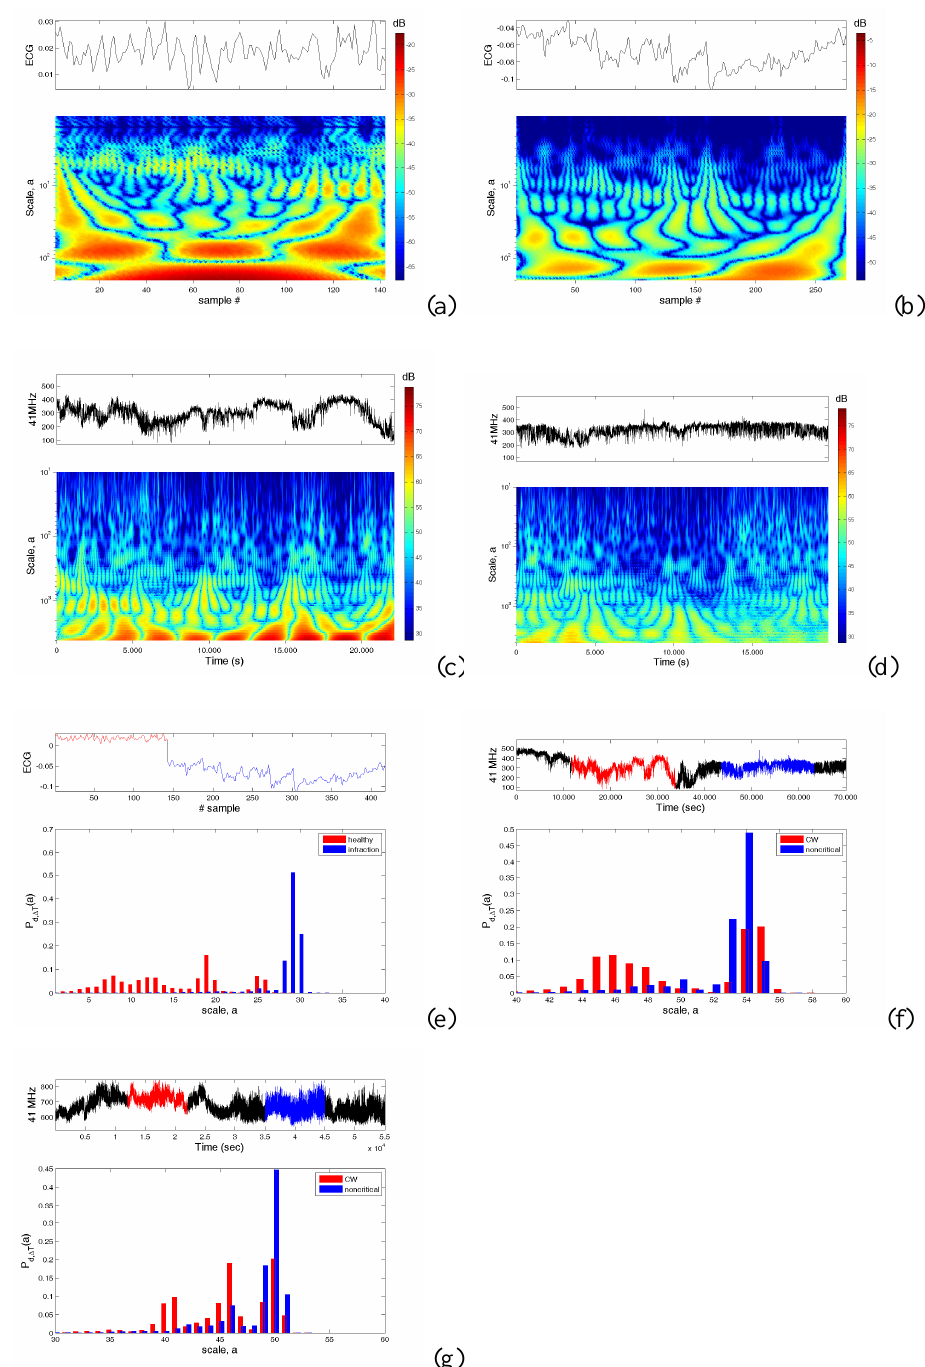
Fig. 5. (a) Morlet wavelet power scalogram (in dB) of an indicative relaxation interval of the healthy heart taken from the ECG time series of the subject “p121”. (b) Morlet wavelet power scalogram (in dB) of an indicative relaxation interval of the pathological heart taken from the ECG time series of the subject “p023”. (c) Morlet wavelet power scalogram (in dB) of the EM emissions CW associated with the Kozani– Grevena EQ. (d) Morlet wavelet power scalogram (in dB) of the noncritical EM emissions associated with the Kozani–Grevena EQ. Energy density of the wavelet marginal spectrum: (e) of an indicative relaxation interval for each one of the healthy and pathological heart ECG time series, (f) of the CW and the noncritical excerpt associated with the Kozani–Grevena EQ, and (g) of the CW and the noncritical excerpt associated with the L’Aquila